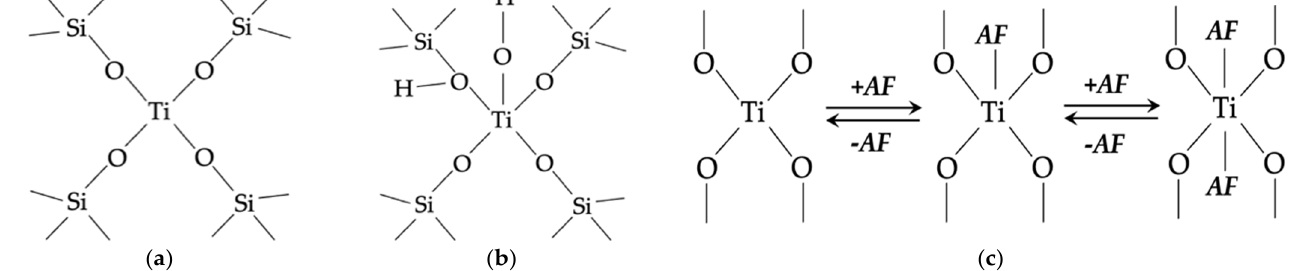
Figure 21. General view of the ‘closed’ Ti(OSi) 4 site ( a ), defective ‘open’ Ti(OSi) 3 (OH) site ( b ) and rearrangement of the titanium atoms coordination environment (AF—atomic formations) ( c ). The schemes on ( a ) and ( b ) correspond to the structures evidenced by dotted and full arrows in Figure 20b.